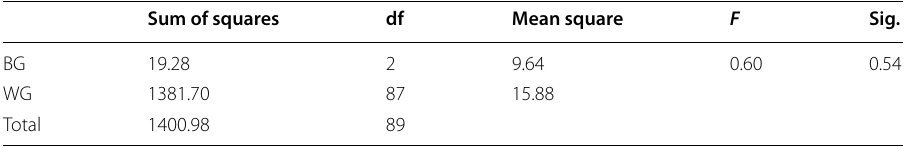
Table 13 Descriptive statistics of cognitive load posttest of all groups N M SD SE CG 30 DigAG DAG